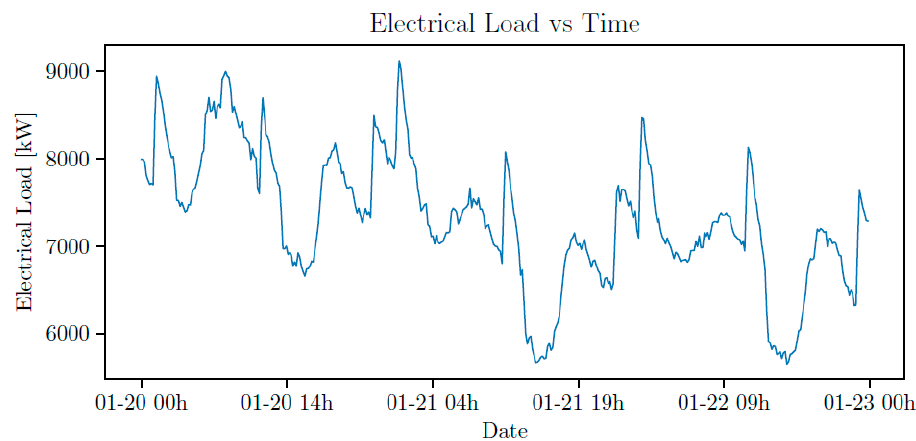
Figure 3. Electrical load measurements.